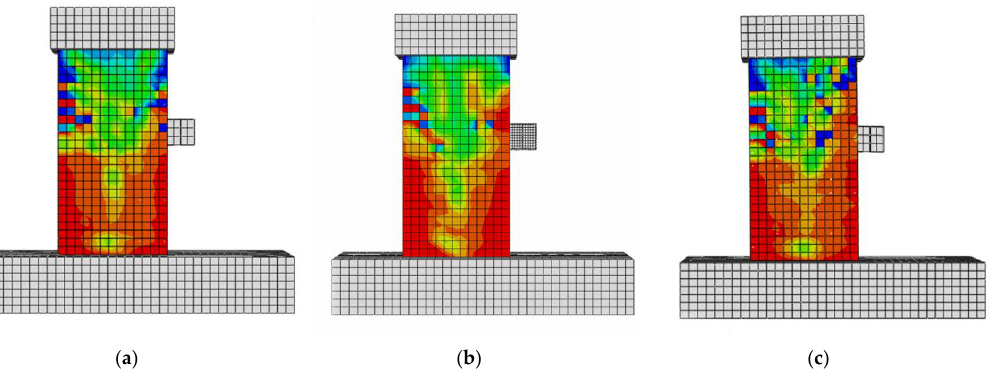
Figure 30. Failure patterns of concrete in three numerical models. ( a ) CS-1; ( b ) CS-2; ( c ) CS-3.